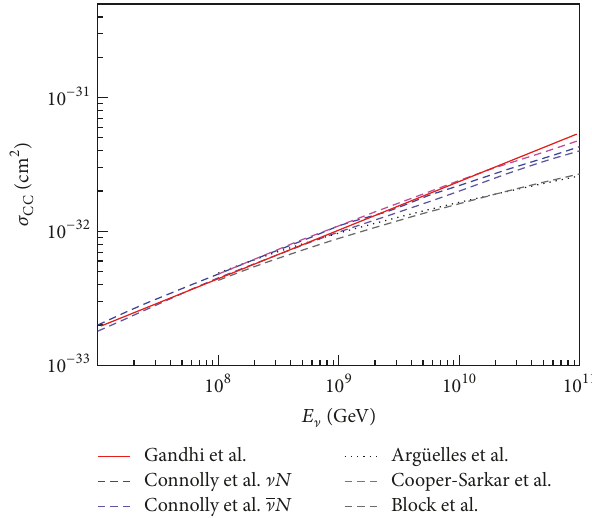
Figure 1: Comparison of the neutrino-nucleon cross section as a function of the neutrino energy, for the model from [37] with those from